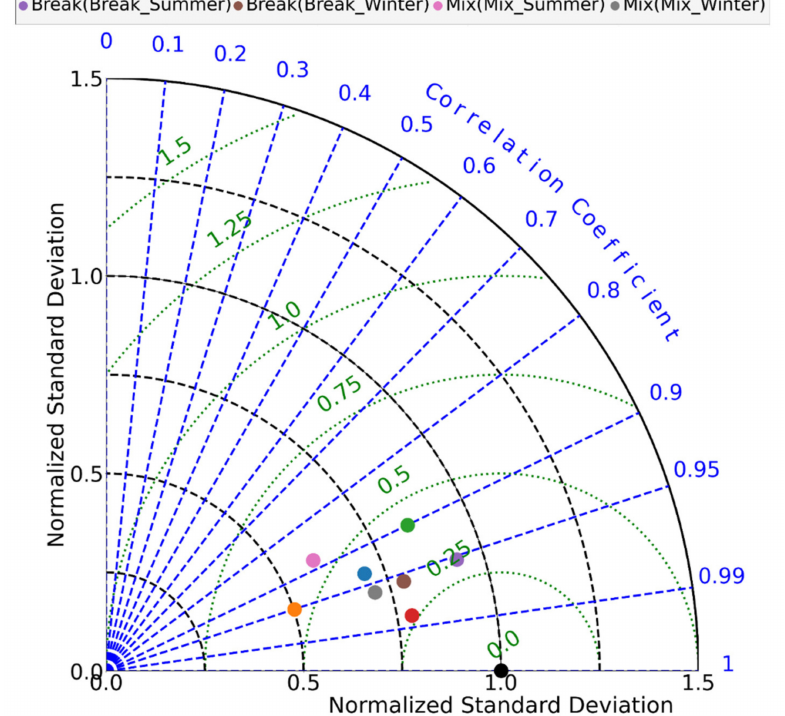
Figure 7. Taylor diagrams displaying statistical comparisons between model simulations from Ctrl, Break and Mix experiments and NSIDC observation. Sea ice concentrations are averaged over the Break_Summer, Break_Winter, Mix_Summer and Mix_Winter locations. The blue line, green line and black lines represent the correlation coefficient, normalized centered root mean square errors and standard deviations, respectively. The NSIDC observation is indicated with the black